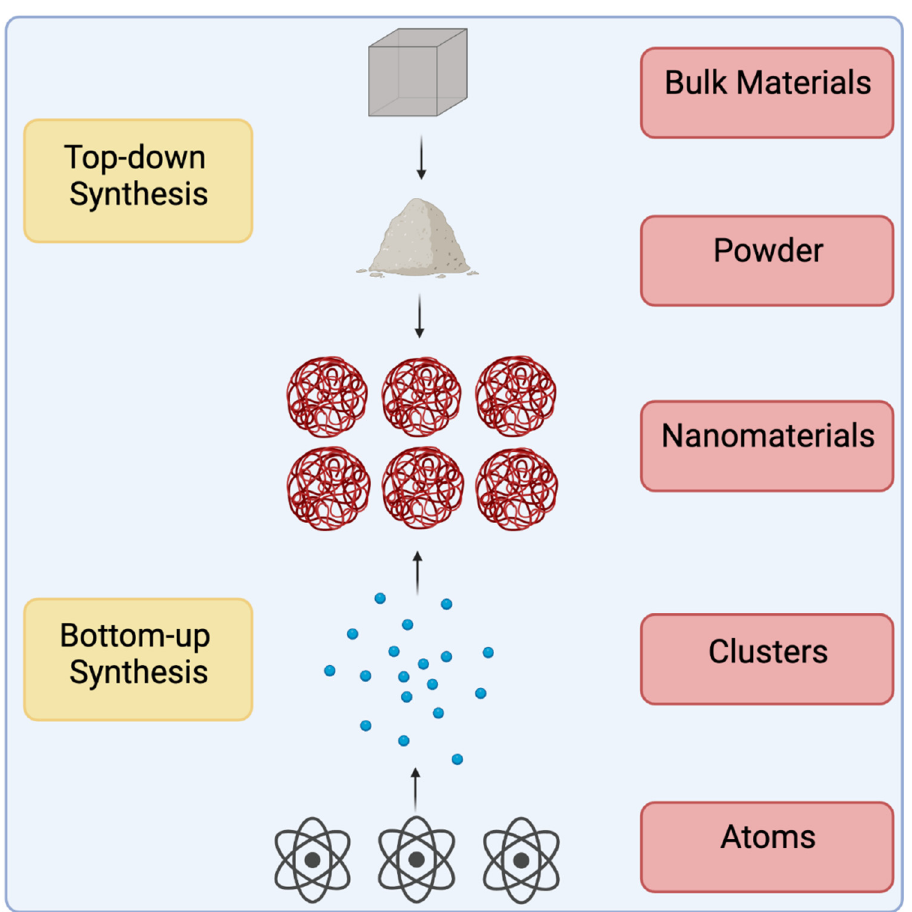
Figure 2. Top-down vs. Bottom-up synthesis schemes. There are two methods by which nanomaterials can be synthesized. Top-down synthesis refers to the process by which bulk materials are broken down into their monomers. Laser ablation is an example of a top-down synthesis method. Bottom-up synthesis refers to the process by which atoms are reacted with other substrates to create the desired nanomaterials. Reactions can be catalyzed by an outside force such as in hydrothermal synthesis, or the introduction of volatile compounds such as in chemical vapor deposition.